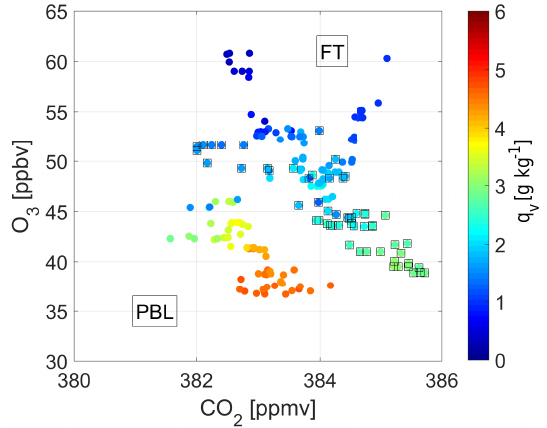
Figure 10. Same as Fig. 9 at noon. The measurement points be- tween 1640 and 2200ma . s . l . (black boxes) are related due to the mixed air masses from the stable layer and the